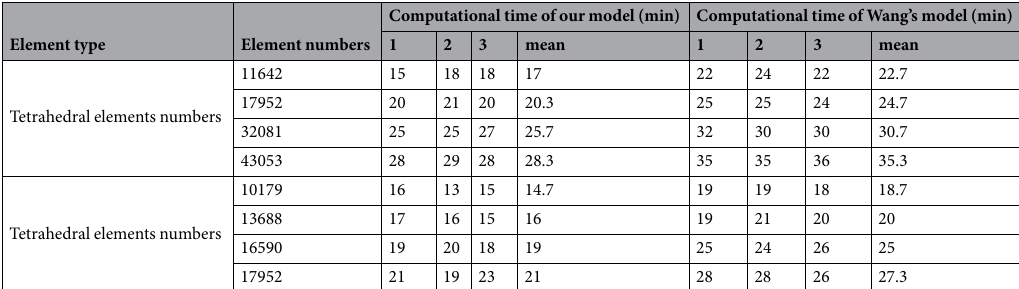
Table 1. Comparison of computational time between our model and Wang’s model 9 under Case